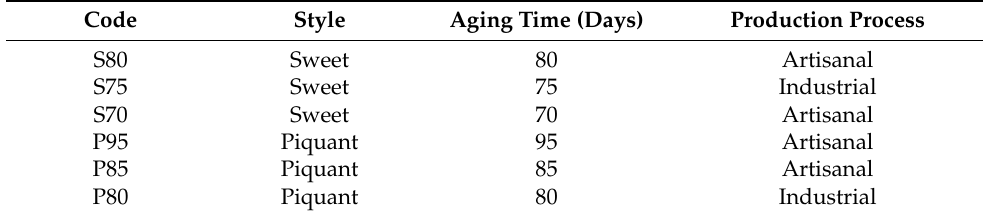
Table 1. Characteristics and codes of the Gorgonzola cheese